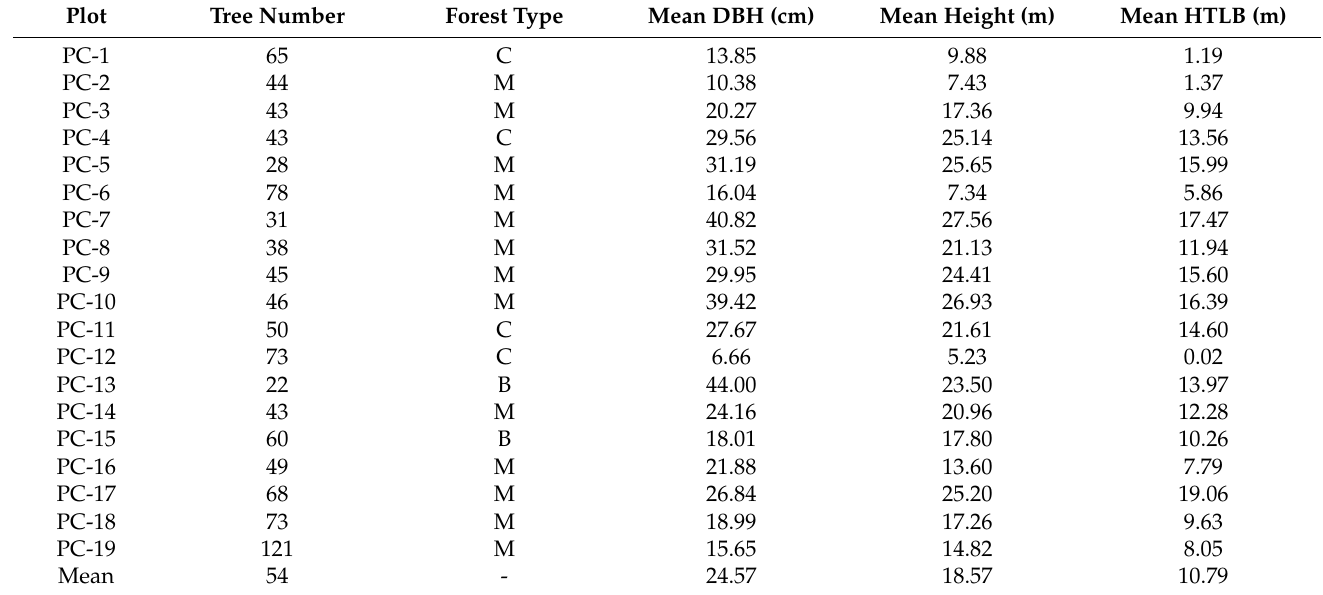
Table 2. Forest plot characteristics in the PC study